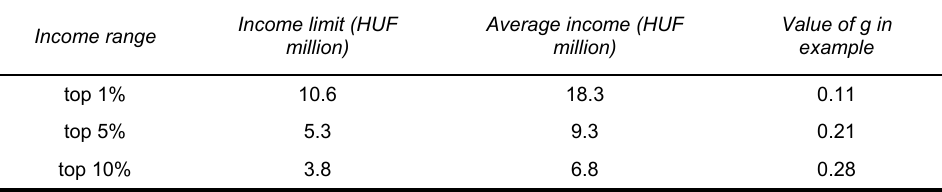
Table 2: Average income of top earners and calculated values of parameter g